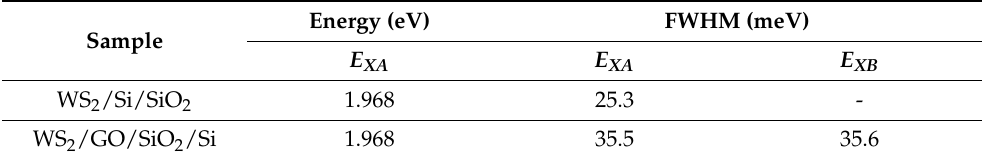
Table 2. Summary of Photoluminescence (PL) studies of WS 2 nanoflakes deposited on different